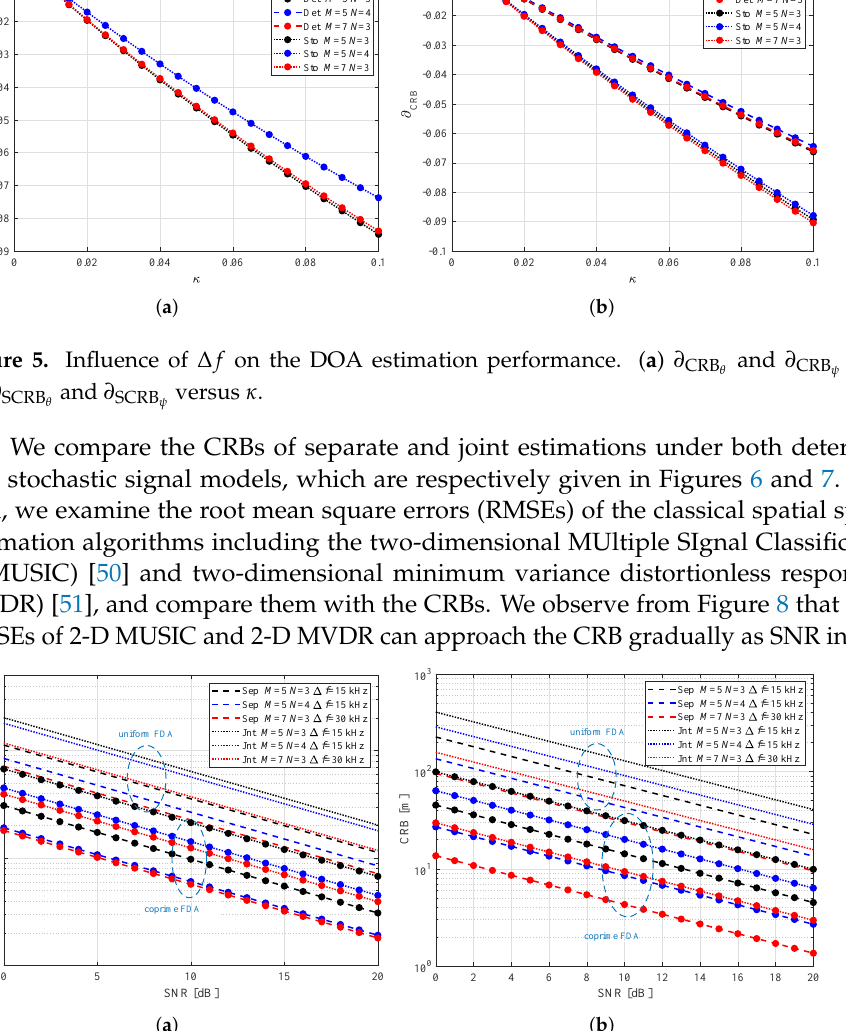
Figure 6. CRBs of joint/separate DOA-range estimations in deterministic signal case. ( a ) CRB of DOA estimation. ( b ) CRB of range estimation.